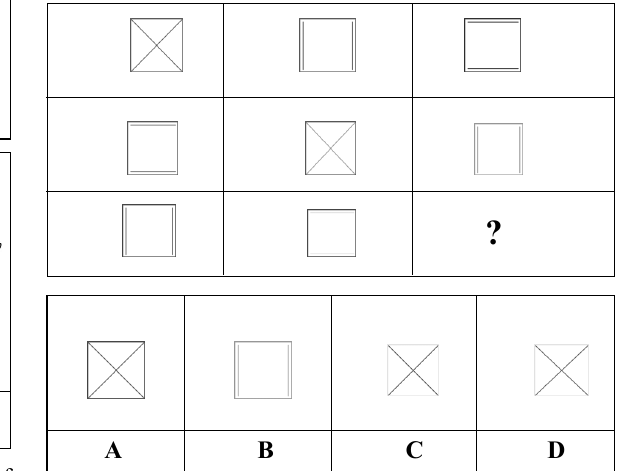
Figure 1 . Item of Generalization/Discrimination (SD) of attributes. Figure 4. Item of System Construction (SC).